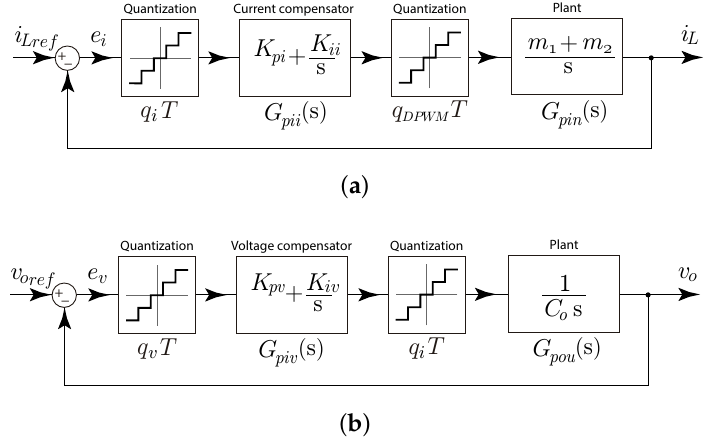
Figure 1. Proportional-integrator control block diagram of ( a ) inner loop dynamic model and ( b ) outer loop dynamic